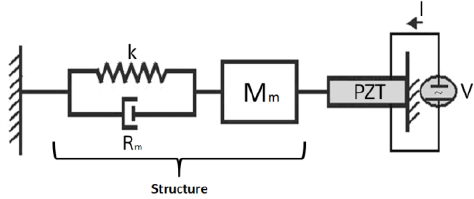
Fig. 1. Model used to represent a single-degree-of-freedom structure containing a PZT